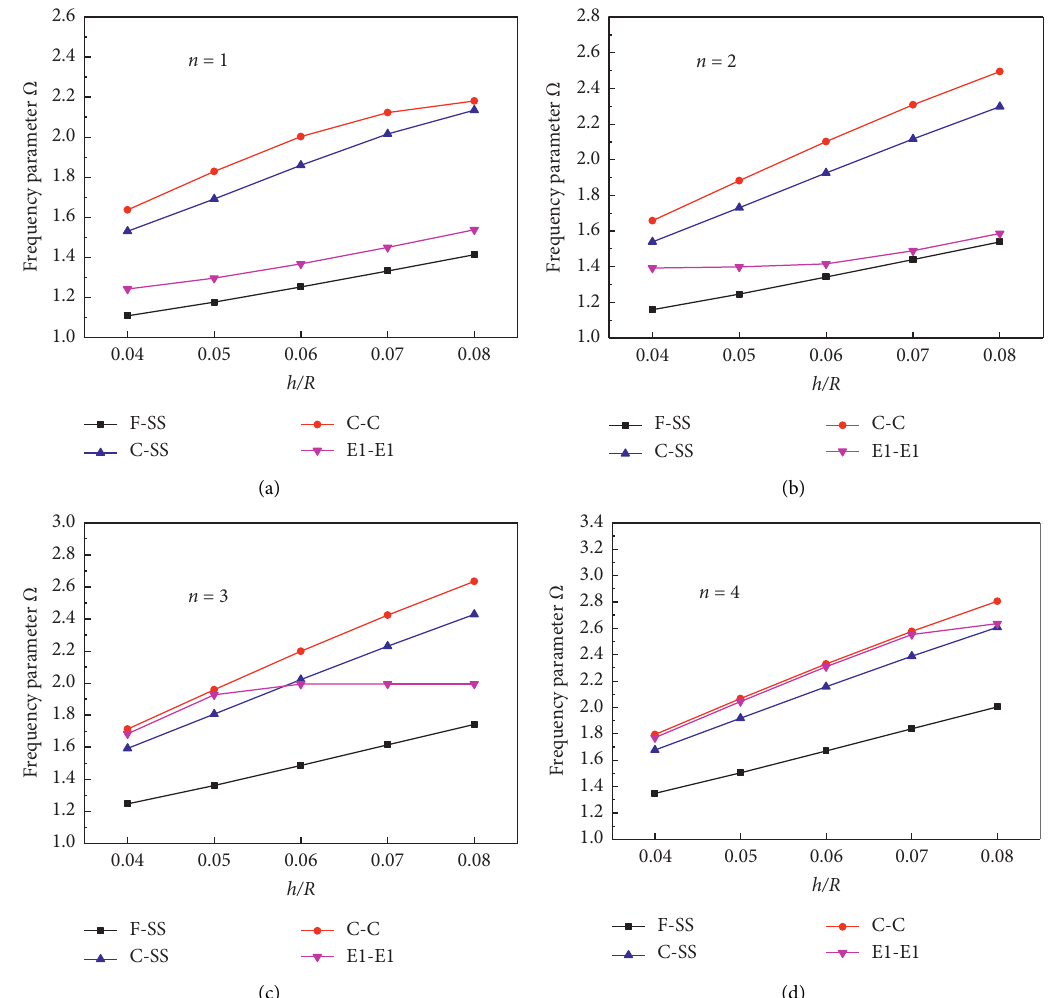
Figure 8: Frequency parameters Ω of the annular spherical shell with different h / R ratios ( m � 3). Table 8: Results of annular spherical shell with different φ